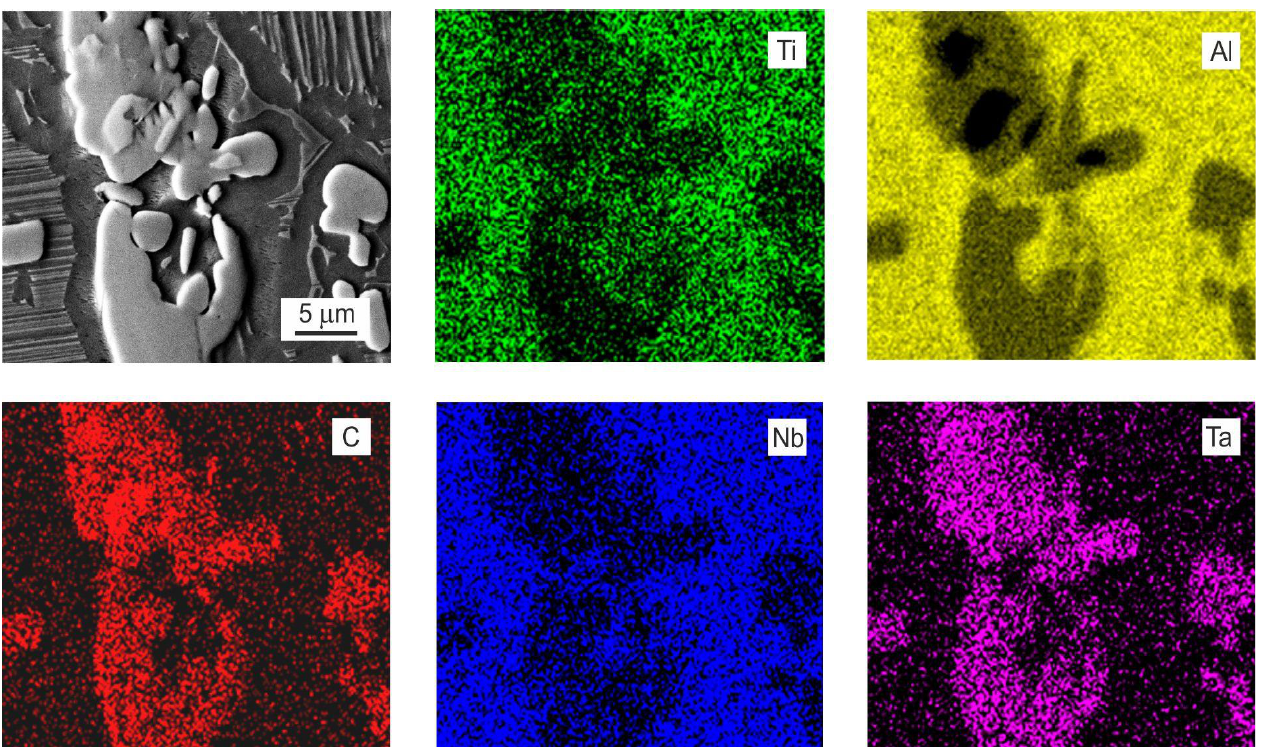
Figure 4. SEM micrograph and corresponding EDS map analysis of the tilt-cast NbTa alloy.